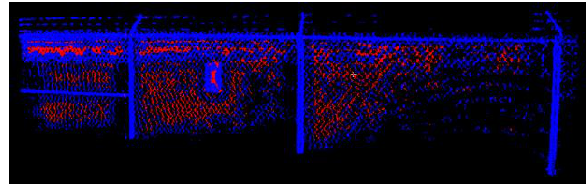
Figure 13. The results of PCA on fence